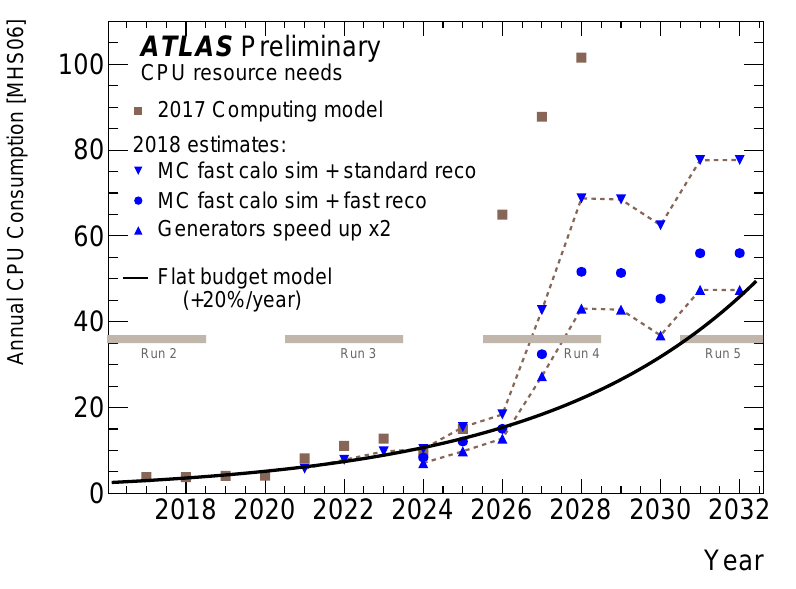
Figure 1. Estimated CPU resources necessary for the years 2018 to 2032 for the ATLAS experiment. Each point shows the necessary computing CPU resources in di ff erent scenarios. The solid line shows the amount of resources expected to be available if a flat funding scenario is assumed